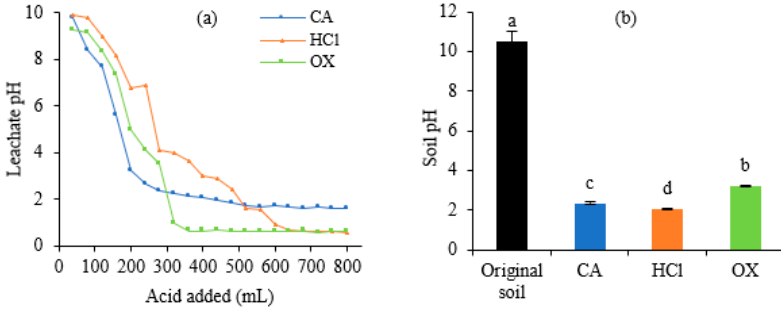
Figure 2. The pH values in the leachates and soils after leaching by different acids. ( a ) Leachates, ( b